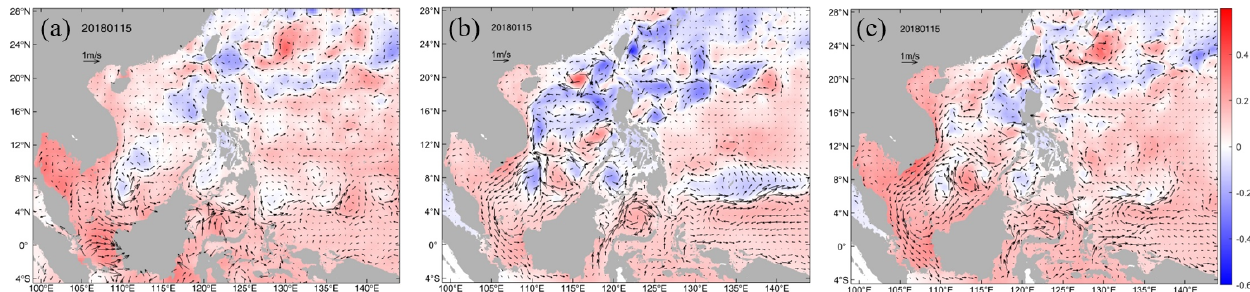
Figure 12. Daily averaged SLA (color shading) and surface velocity anomaly (vectors) on 15 January 2018 from AVISO, SCSOFSv1.3, and